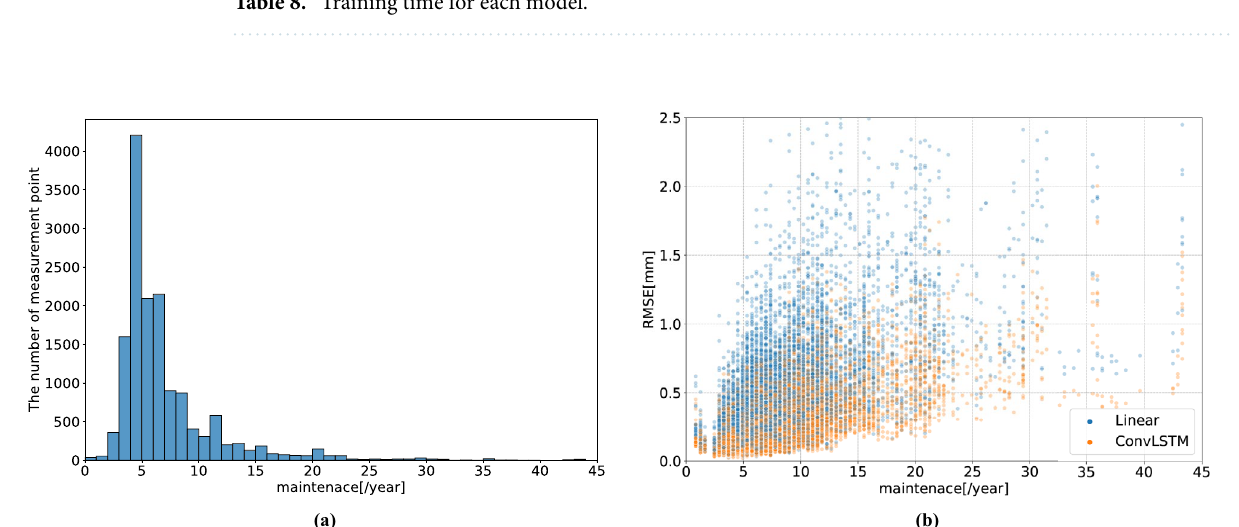
Figure 5. ( a ) Histogram of the number of maintenances at each spatial point on the rail. ( b ) Scatter plot of the number of track maintenances and RMSEs at each measurement point.